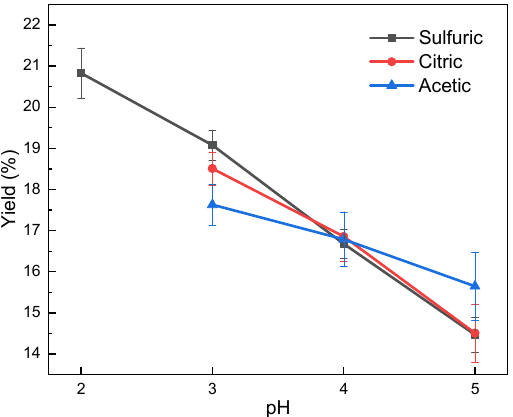
Figure 1. Yield of the isolated lignin in various pH and acid types.